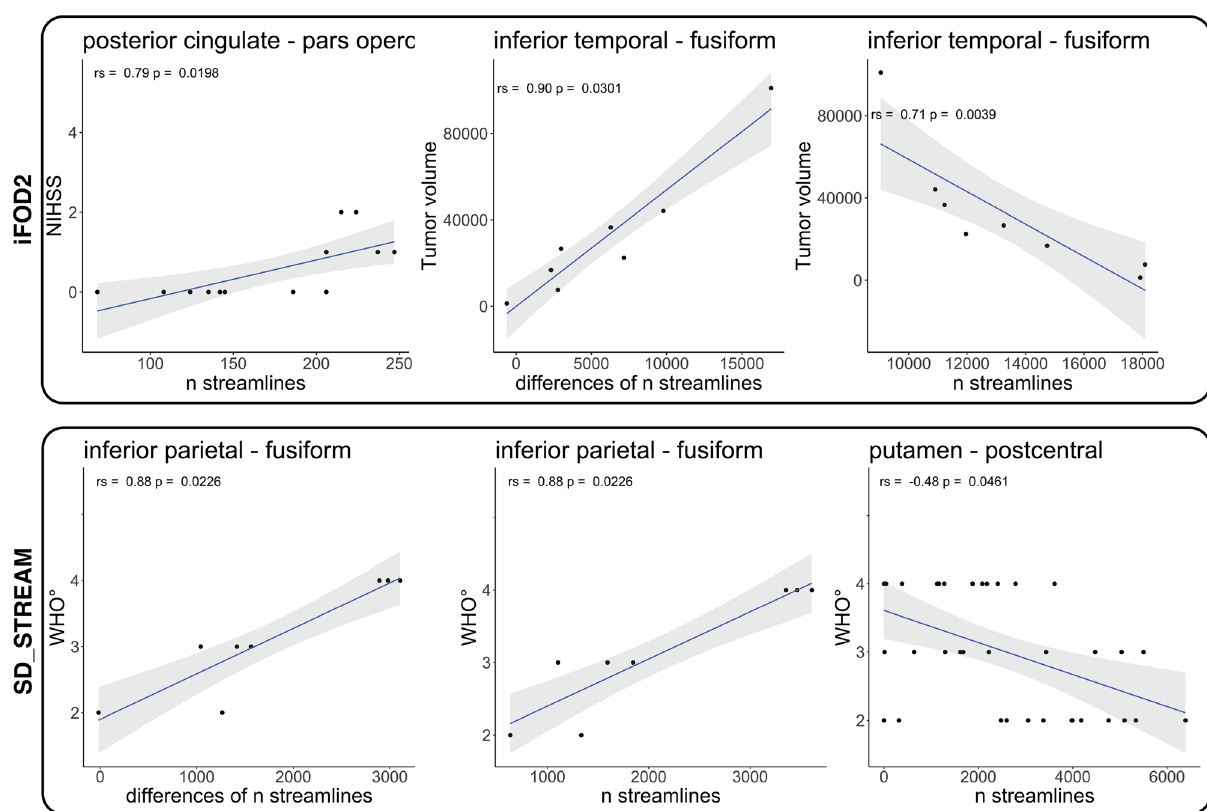
Fig. 3 Spearman correlations of TFNBS-selected signi fi cant edges. Line plots of signi fi cant FDR-corrected Spearman correlations between TFNBS- selected signi fi cant edges and NIHSS, WHO grade or tumor volume for both tractography algorithms (iFOD2 &